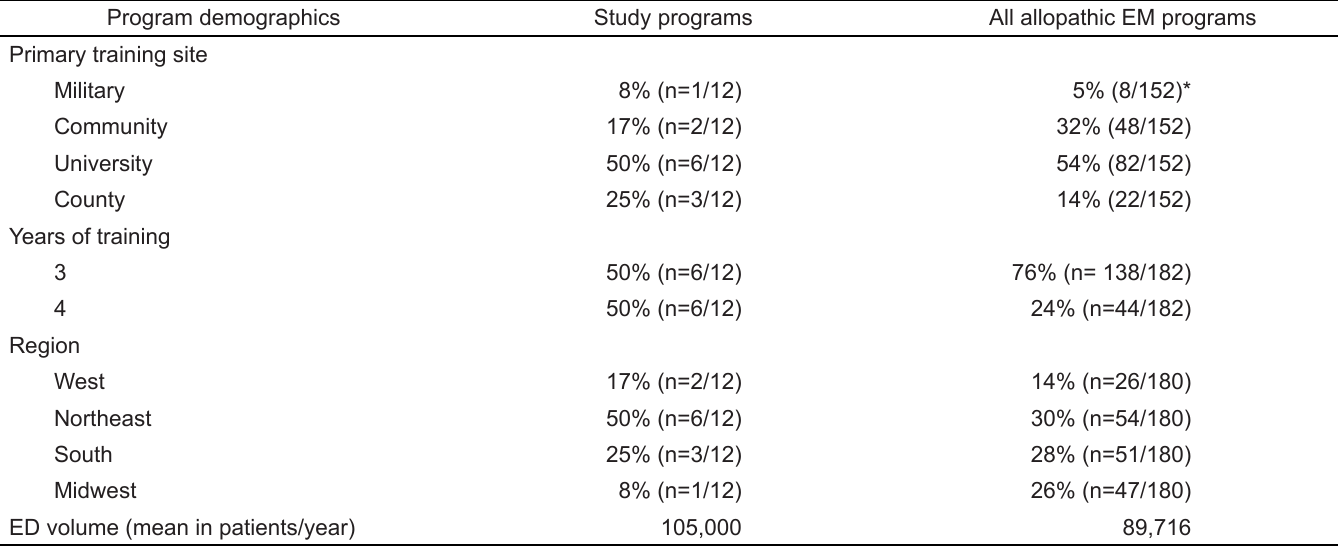
Table 2. Demographic data of programs involved in the study of podcast use, and all allopathic EM